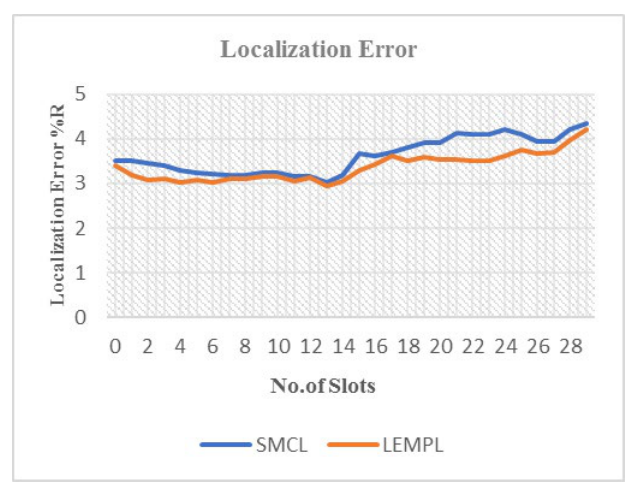
Figure 4. Number of Samples taken to Complete localization (Mobile Nodes n=100, Anchor Nodes N=10)